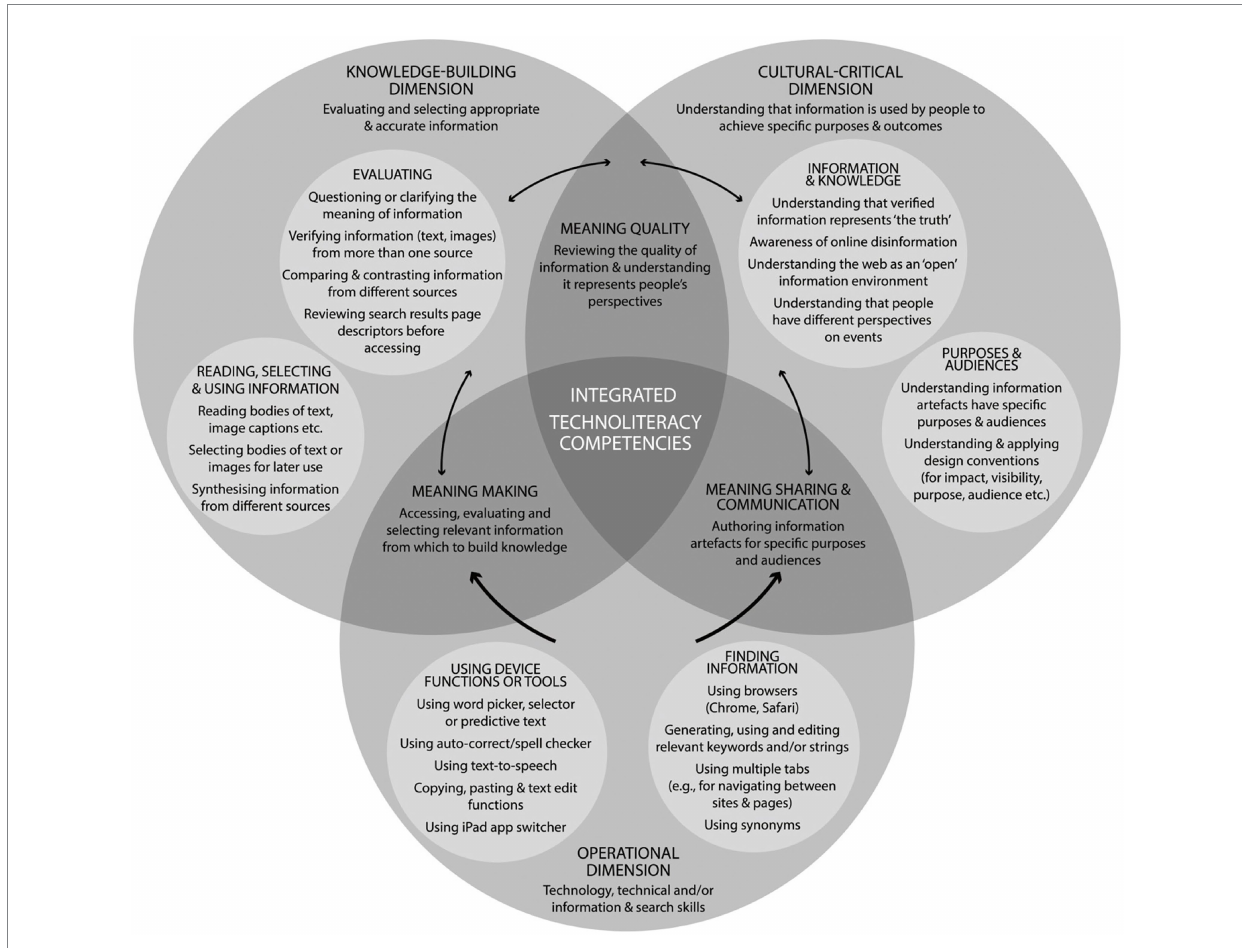
FIGURE 5 The interaction between ‘Technoliteracy’ dimensions (Falloon,